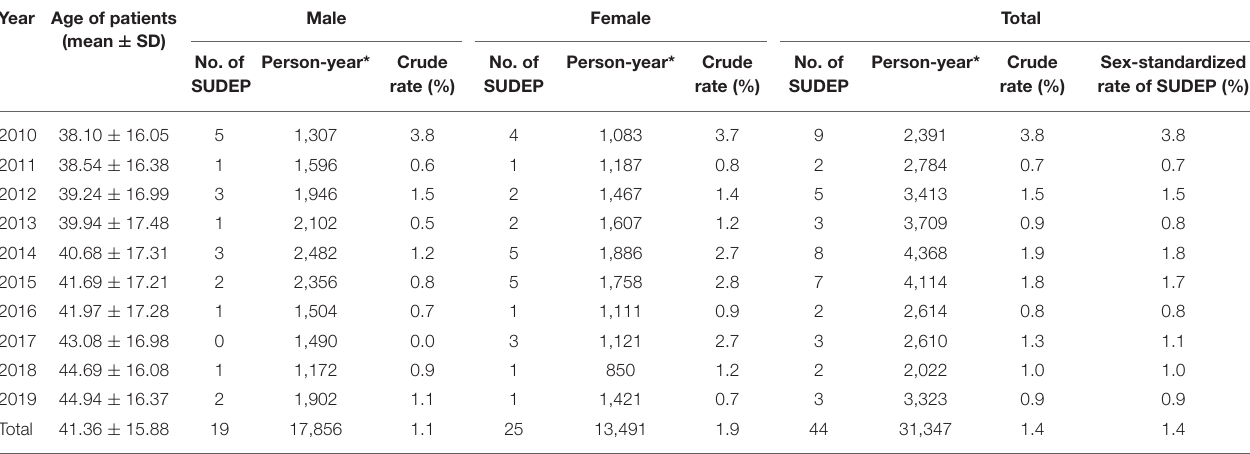
TABLE 2 | Trend of SUDEP incidence rate in 2010–2019. Year Age of patients (mean ± SD)